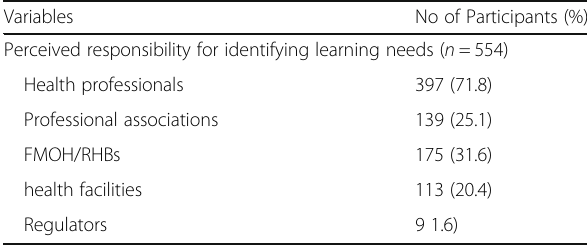
Table 5 Experiences regarding CPD, exploring health workforce regulation practices and gaps, Ethiopia, 2015 ( N = 554)